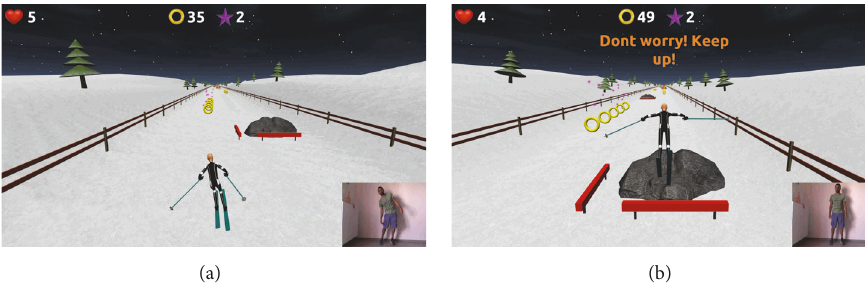
Figure 15: Slope Creep game. (a) Sample screenshot showing the human actor (bottom-right insert) leaning to the left to avoid a rock; (b) sample screenshot of the avatar animation that is triggered after colliding with an obstacle.